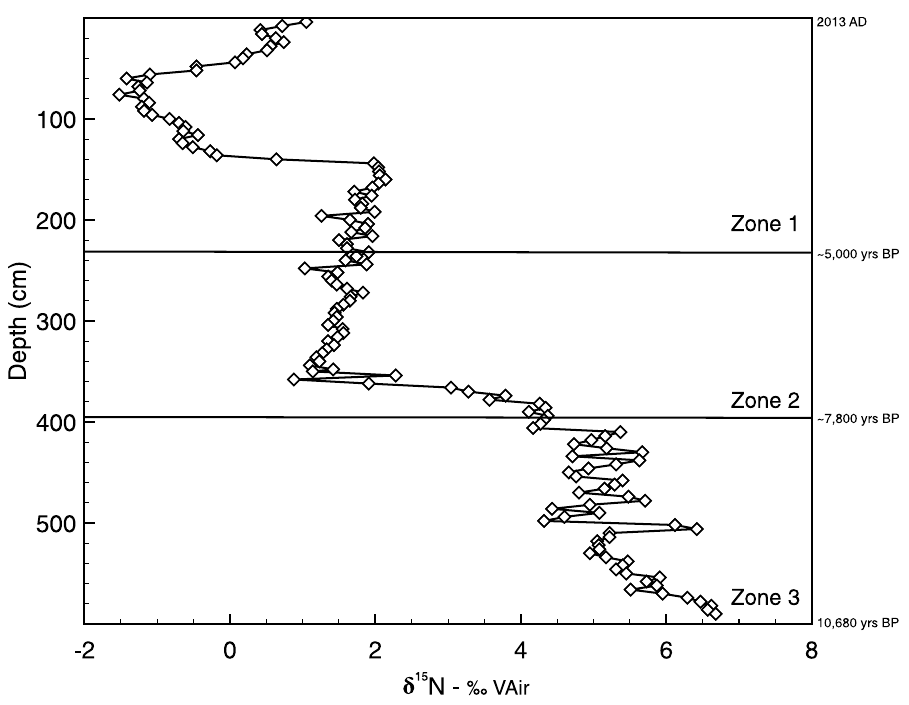
Fig 4. Nitrogen isotope values ( δ 15 N) versus depth in the Lake Harris core. Shifts in δ 15 N in the Lake Harris core. Core zones are delineated with solid horizontal lines, and labeled accordingly.